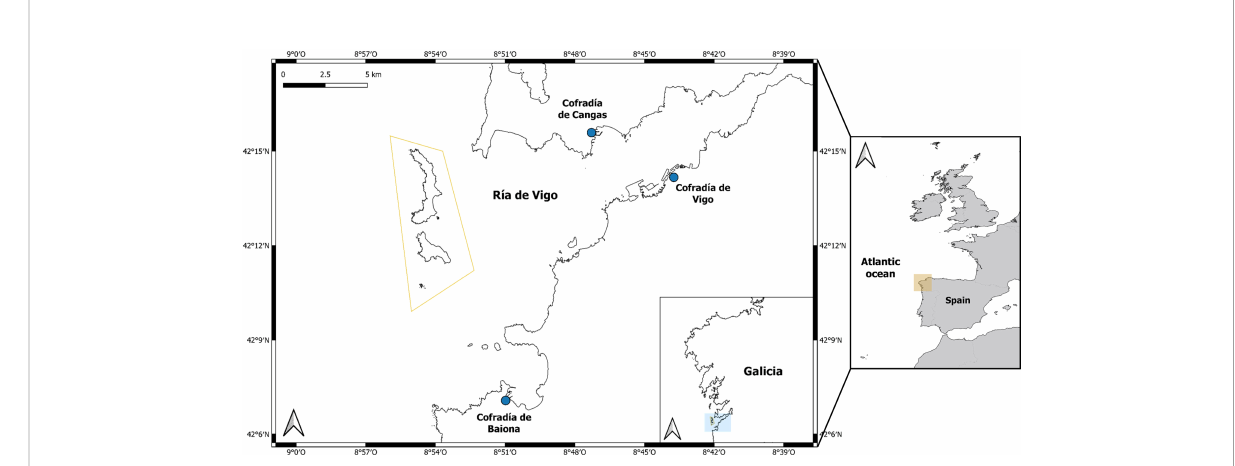
FIGURE 1 Map showing the study area (colored boxes) and the location of the three cofrad ı ́ as involved in the study. Polygon is the National Park